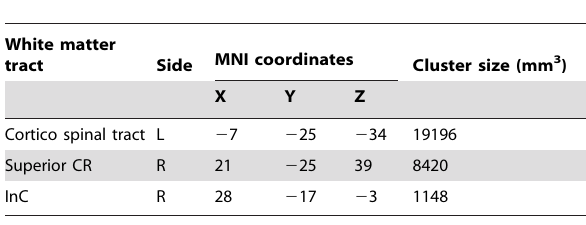
Table 3. Relationship between axial diffusivity and age in